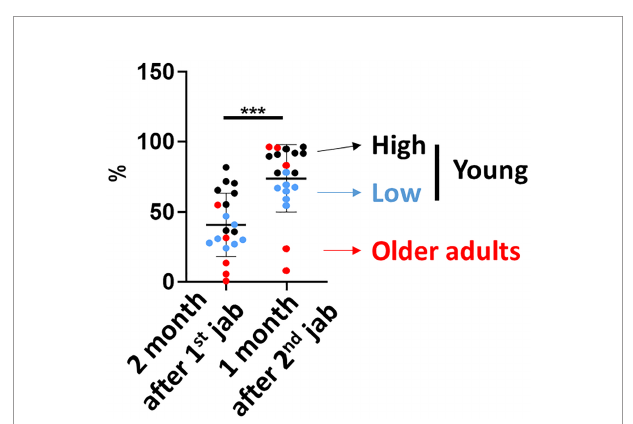
FIGURE 4 | Neutralization antibody titers 2 months after the fi rst vaccination correlated with neutralization antibody titers 1 month after the second vaccination. The SARS-CoV-2 surrogate virus neutralization antibody titers (sVNT) were measured 2 months after the fi rst vaccination and 1 month after the second vaccination. The high sVNT, low sVNT and older adult group all demonstrated higher sVNT 1 month after the second vaccination than 2 months after fi rst vaccination. Statistical signi fi cance was determined using Wilcoxon signed rank test between 2 groups. (*** p value <